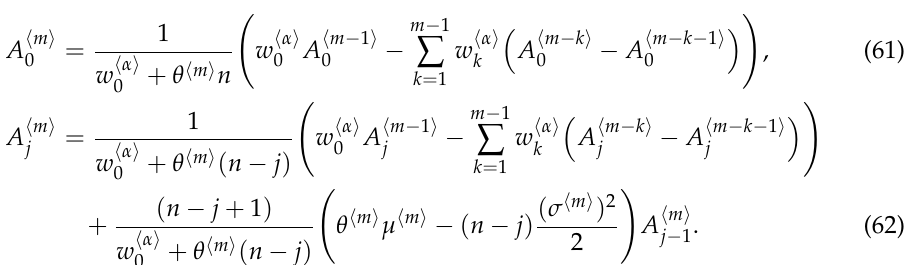
Figure 8. The behaviors of the approximate solutions u ( a ) The 1st-moment u